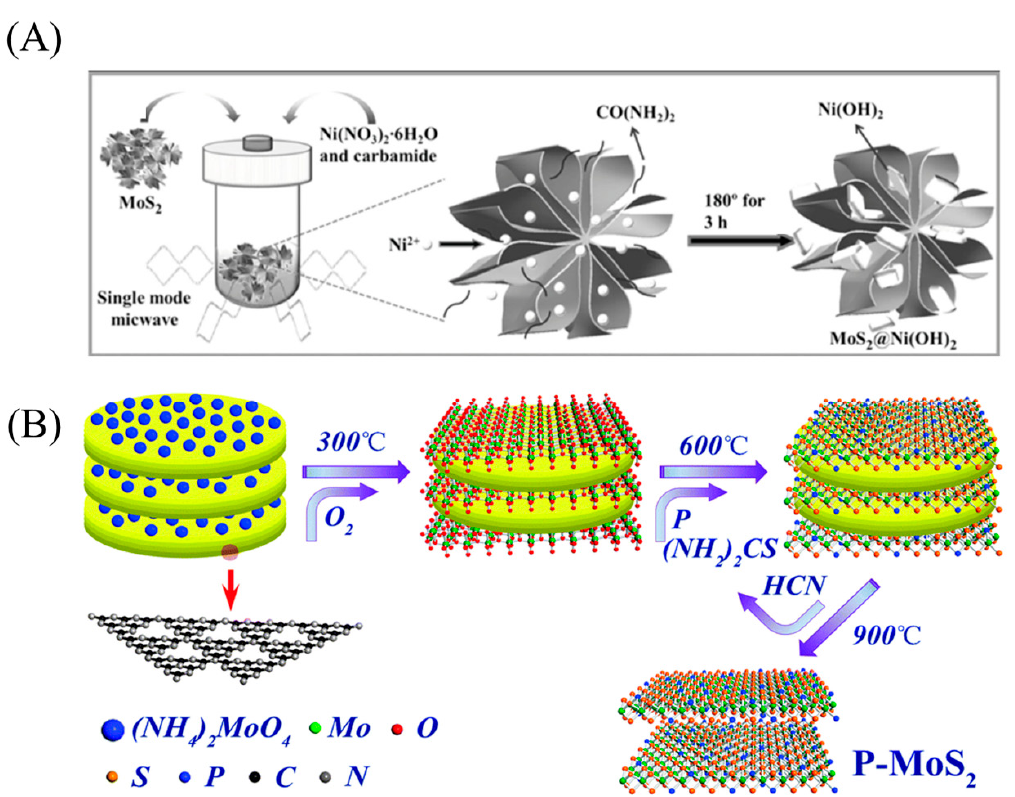
Figure 4. ( A ) Schematic illustration for the formation of self-supporting three-dimensional hierarchical nanostructure MoS 2 @Ni(OH) 2 nanocomposites. Reproduced with permission from [70] Copyright © 2021 WILEY-VCH. ( B ) Proposed synthetic protocol for ultrathin P-MoS 2 nanosheets. Reproduced with permission from [46] Copyright © 2021 The Royal Society of Chemistry.